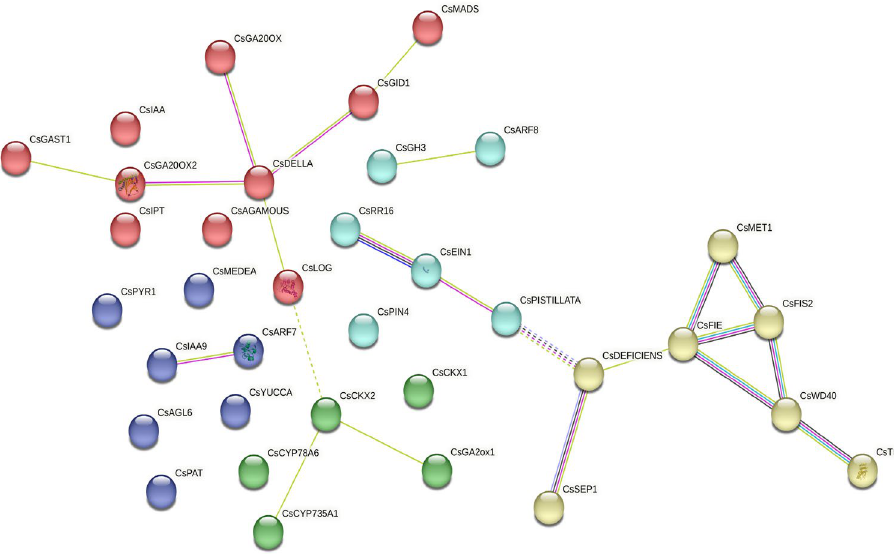
Figure 7. Protein–protein interactions (PPI) of parthenocarpy related genes constructed using Cytoscape. Dotted lines represent edges between clusters.